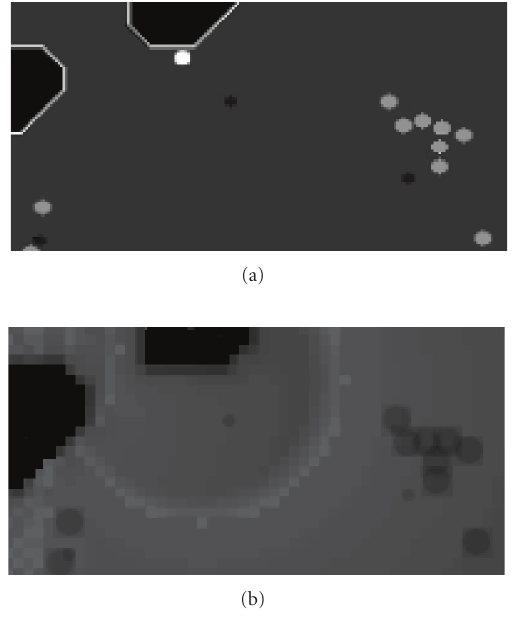
Figure 2: Part of the map during a tankbattle game. The upper picture shows our agents (light-grey circles), an opponent unit (white circle), and three sheep (small dark-grey circles). The lower picture shows the total potential field for the same area. Light areas have high potential and dark areas have low potential.